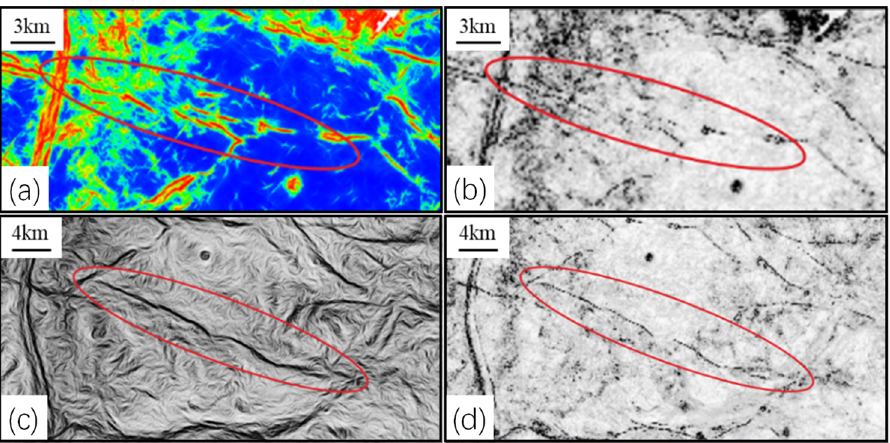
Figure 5. Comparison of ( a ) the planar maximum likelihood attribute and its counterpart of coherence attribute ( b ), and ( c ) coherence attributeand ( d ) its steerable pyramid process in imagining the strike-slip faults in Anyue Gasfield (the red circle highlighting the comparison images of the fault network).